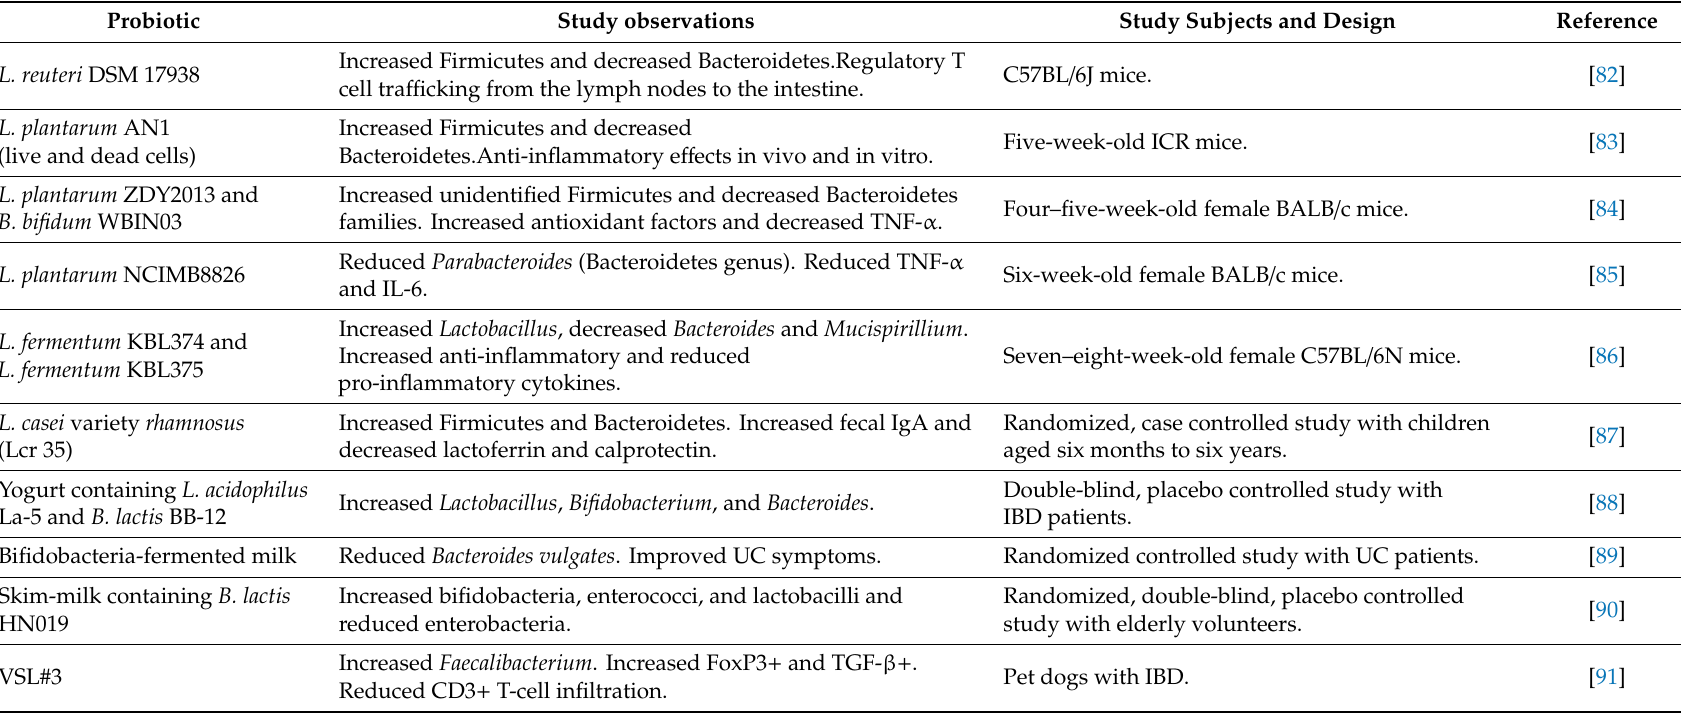
Table 2. Probiotics and their anti-inflammatory e ff ects via F / B ratio